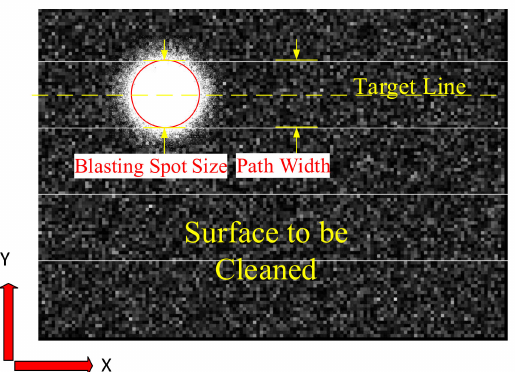
Figure 2. A surface subjected to a tele-abrasive operation where the blasted spot is controlled along the target line to blast the